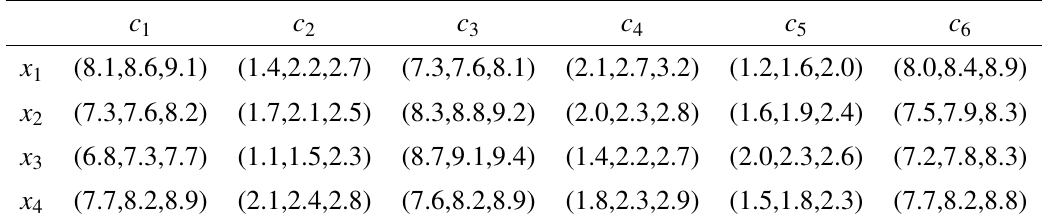
Table 3: Decision matrix given by DM2 after the first round of interactive procedure